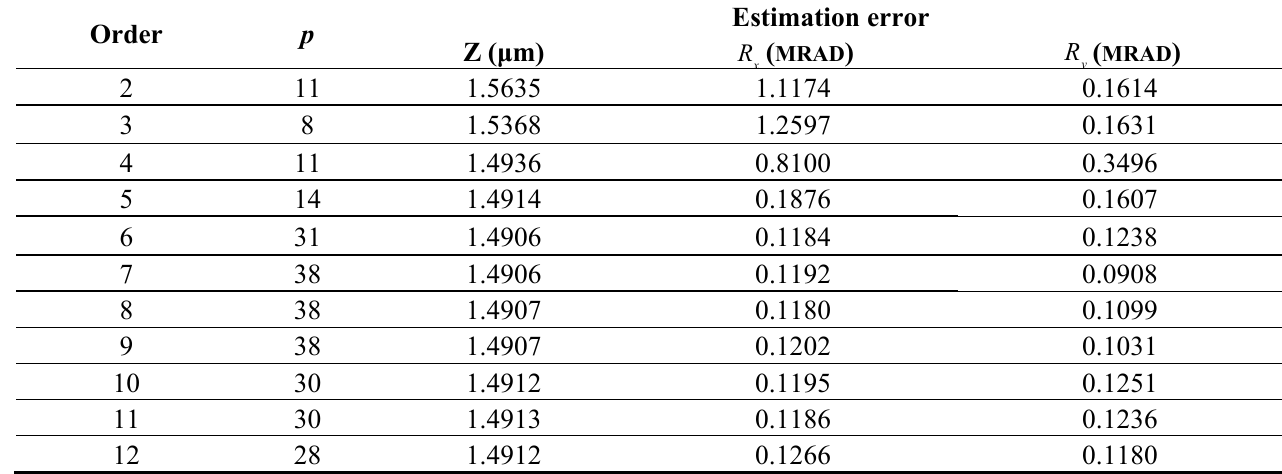
Table 4. Estimation error from the chirp inputs in channel 1.